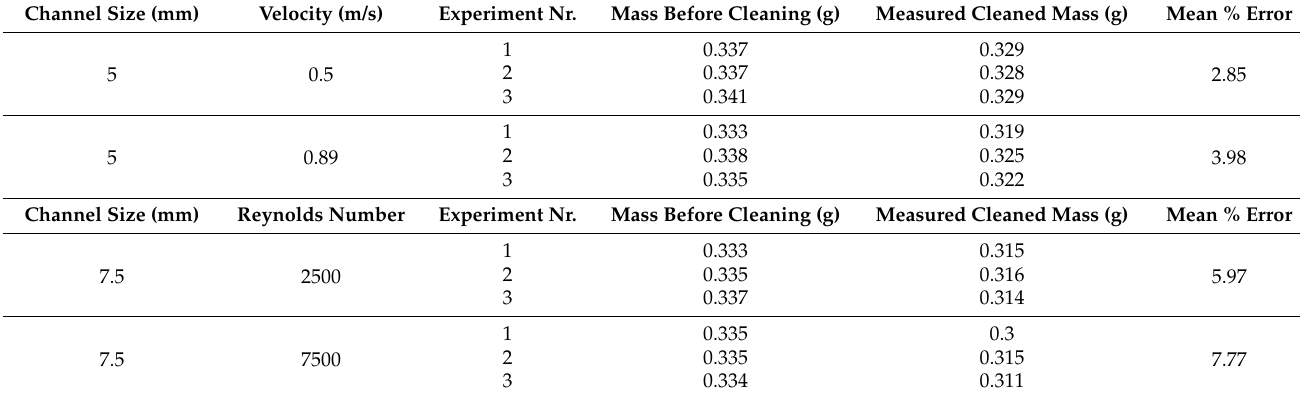
Table A1. Feasibility of the cleaning tests.